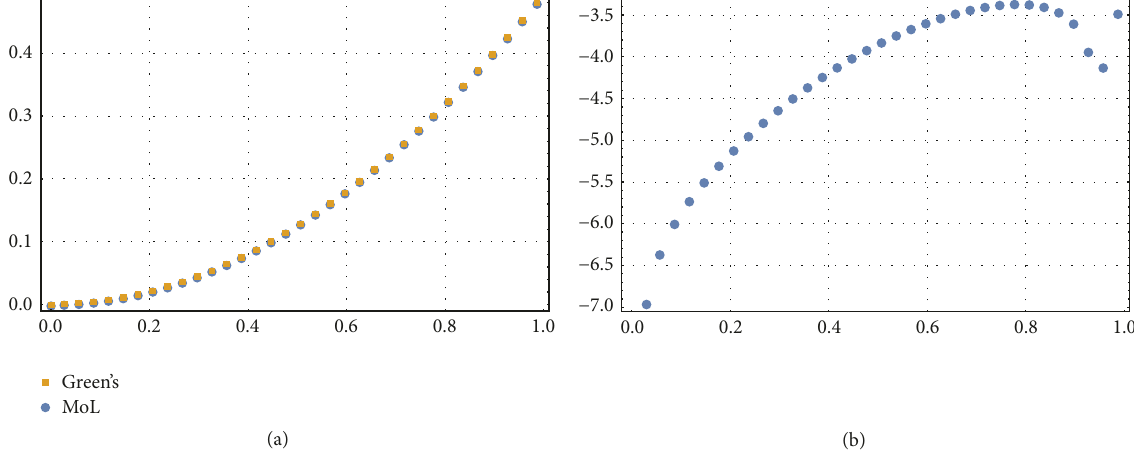
Figure 2: Discrete plot of 𝑤 and 𝑤 MoL (a) and Er (b) against 𝑡 ∈ [0, 1] for 𝑓(𝑡) = 𝜃(𝑡) : quadratic potential. Green’s